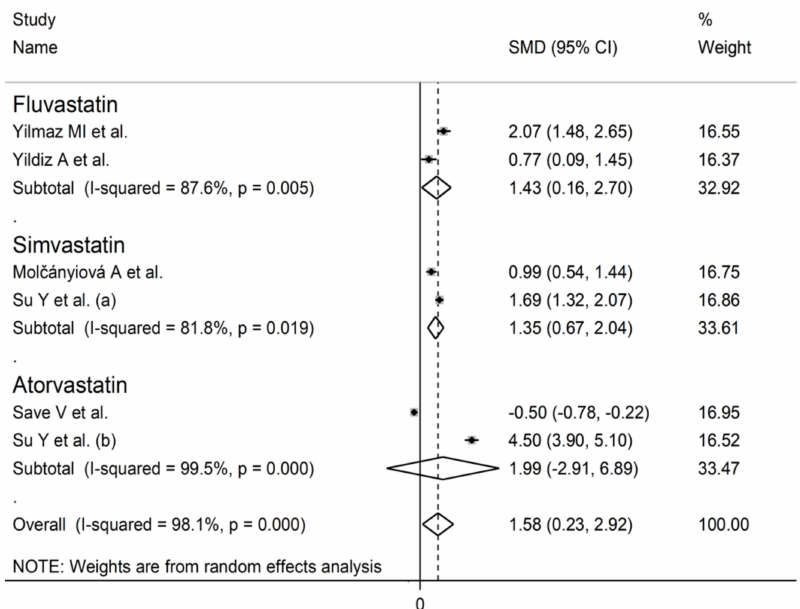
Figure 5. Forest plot of studies of individual statins on GPx